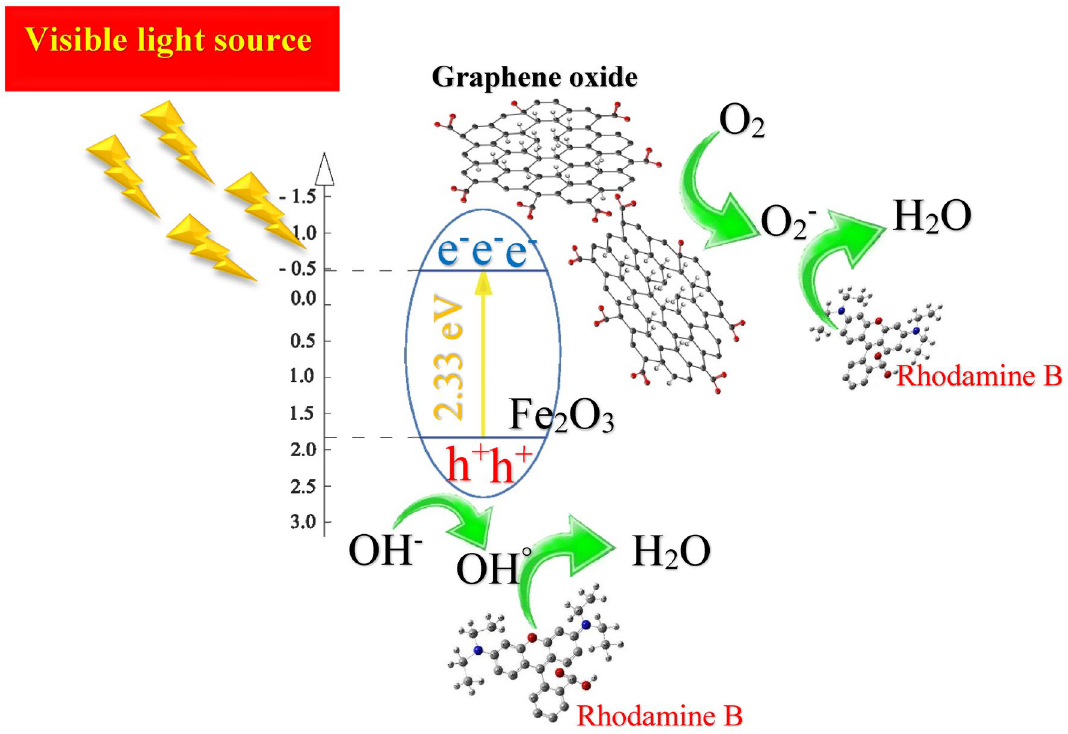
Figure 12. The photodegradation mechanism of RhB with α-Fe2O3/GO thin films.